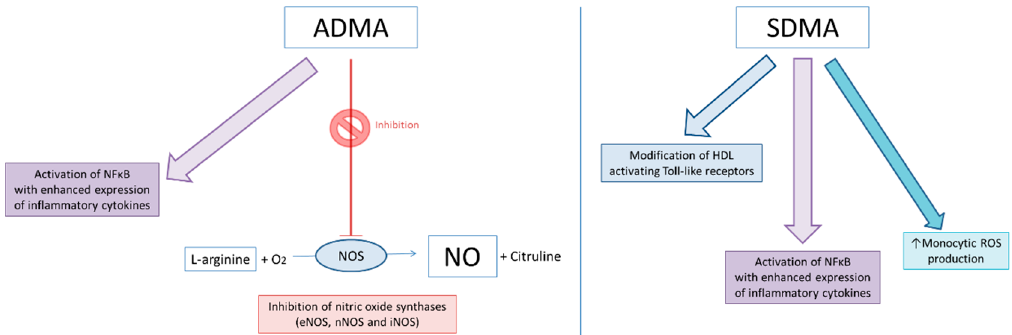
Figure 2. Biological e ff ects of ADMA and SDMA. ADMA’s most relevant known biological e ff ect is the inhibition of nitric oxide synthases [endothelial nitric oxide synthase (eNOS), neuronal nitric oxide synthase (nNOS) and inducible nitric oxide synthase (iNOS)] [2]. However, it has also been shown to induce activation of NF κ B, with enhanced expression of inflammatory cytokines [31] and a weak inhibition of L-arginine transport [32]. SDMA does not inhibit nitric oxide synthases [2], but may have a possible weak indirect inhibition [24]. Like ADMA, SDMA produces activation of NF κ B with enhanced expression of inflammatory cytokines [31] and a weak inhibition of L-arginine transport [32]. However, SDMA di ff ers from ADMA by increasing monocytic reactive oxygen species (ROS) production by activation of calcium channels [33] and modification of high-density lipoprotein (HDL), activating Toll-like receptors [22].